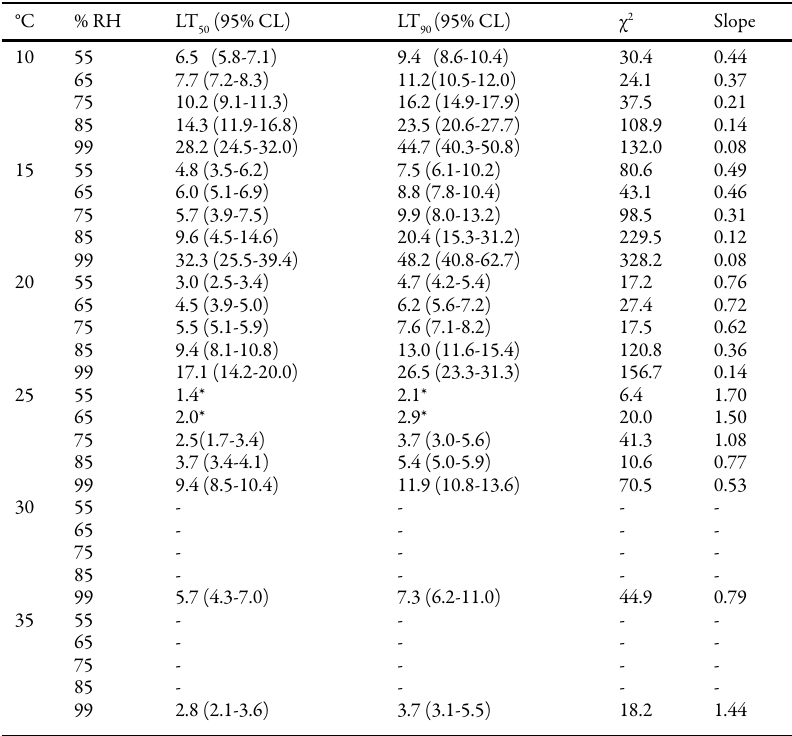
Table 1. Lethal times (days) and lower and upper confidence limits for small groups of C. formosanus exposed to combinations of six temperatures and five relative